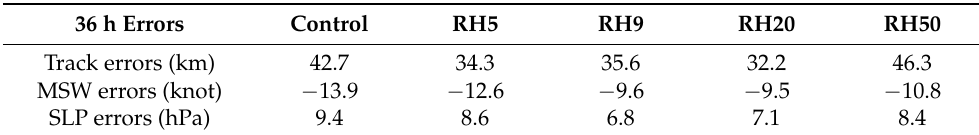
Figure 7. Comparison of the forecast track for Hurricane Earl from different TDR data thinning experiments against Control and best track at 18 UTC 2 August 2016.